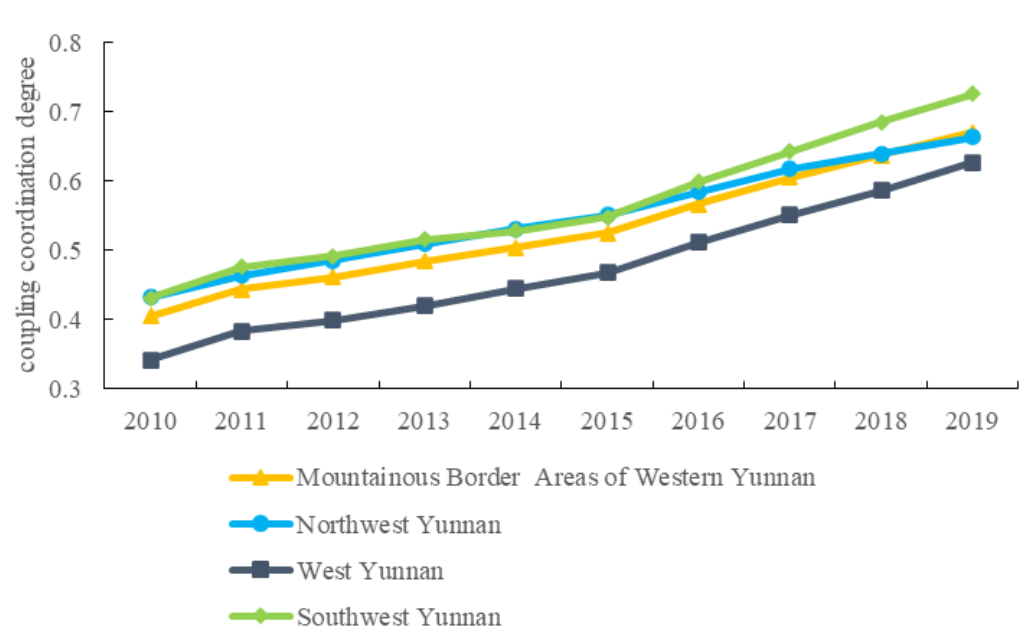
Figure 5. The change trend of coupling coordination degree of tourism industry and urbanization.